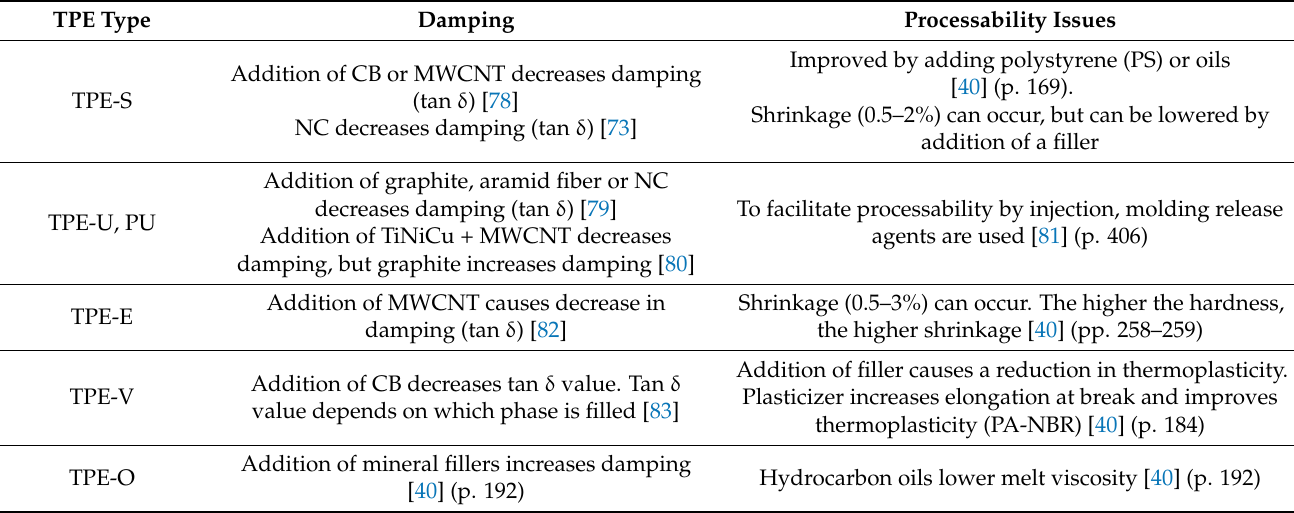
Table 3. Main types of thermoplastic elastomers and influence of fillers on mechanical properties, damping capacity and processability; PA-NBR compound of polyamide (PA) and butadiene-acrylonitrile rubber.